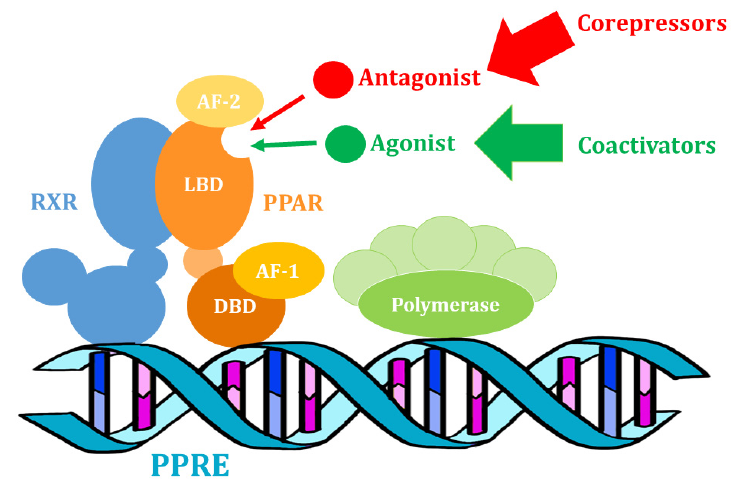
Figure 1. The actions of PPAR proteins: Activation of transcription of target genes involving PPAR–RXR heterodimers and coactivators (own elaboration, after: Brunmeir and Xu 2018 [46]). RXR—retinoid X receptor; PPAR—peroxisome proliferator-activated receptor; PPRE—PPAR response ele- ment; DBD—DNA binding domain; LBD—ligand binding domain; AF-1—activation function 1 do- main; AF-2—activation function 2 domain.